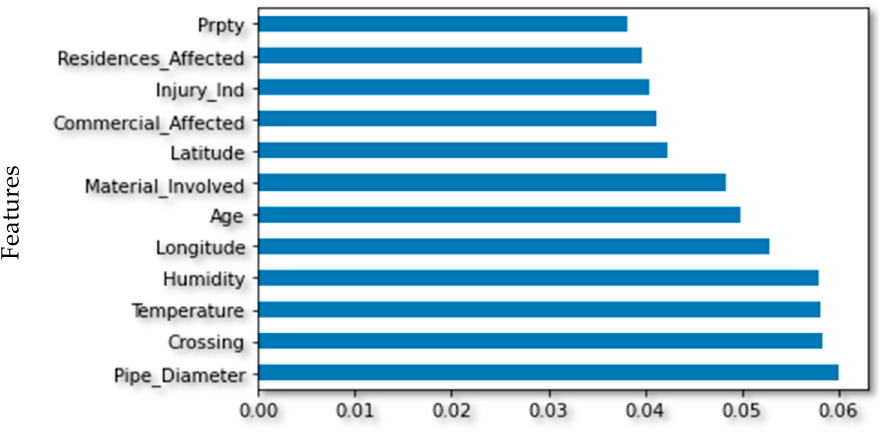
Figure 4. Results from the feature selection process.